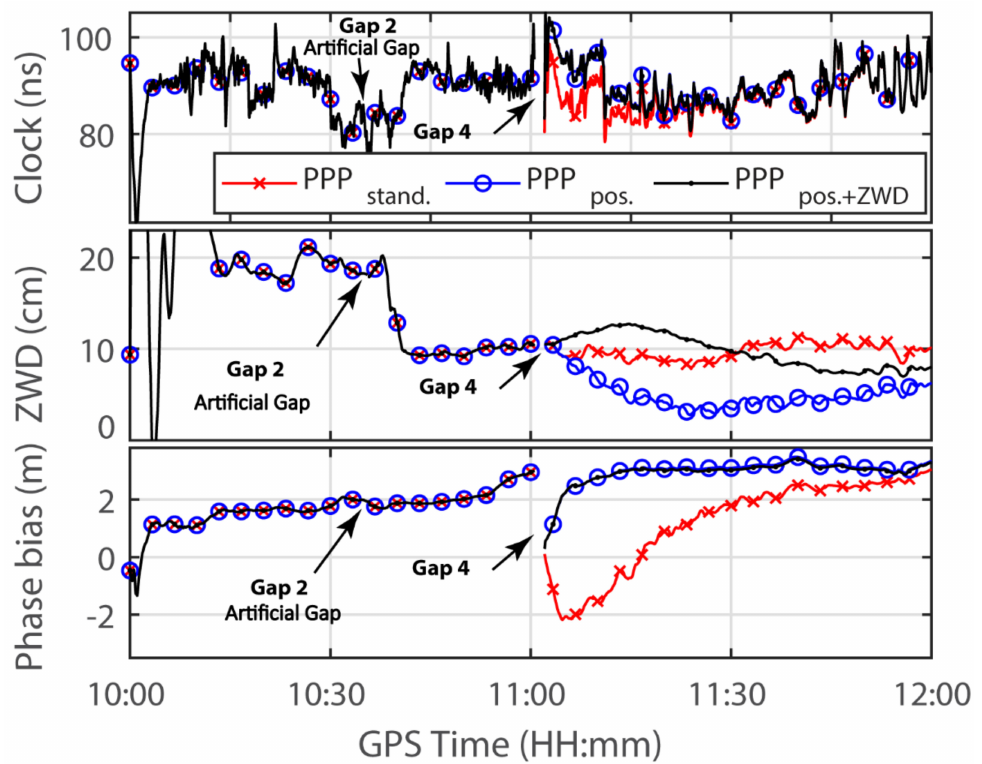
Figure 6. Bridge surveying point B receiver clock, ZWD and tracking GPS satellite phase bias (PRN11) from standard PPP and constrained PPP over 2